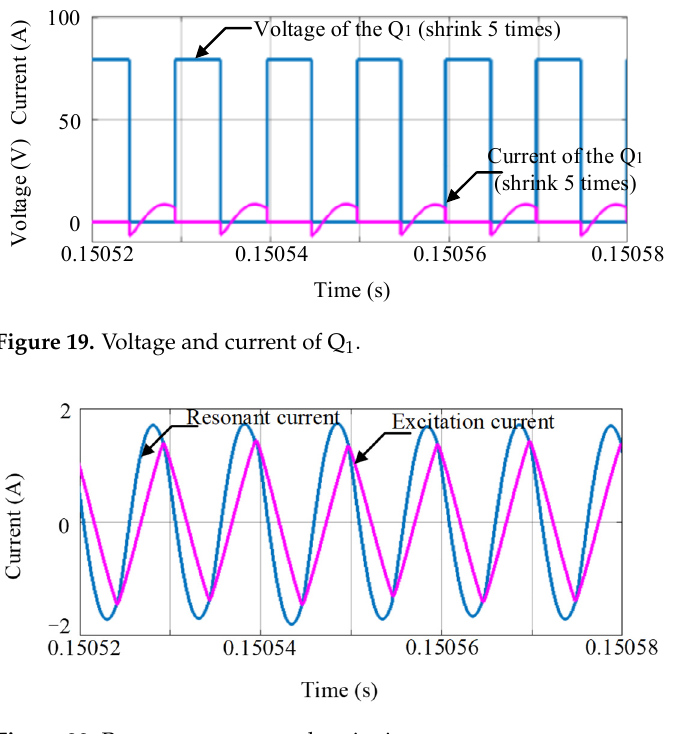
Figure 20. Resonant current and excitation current.